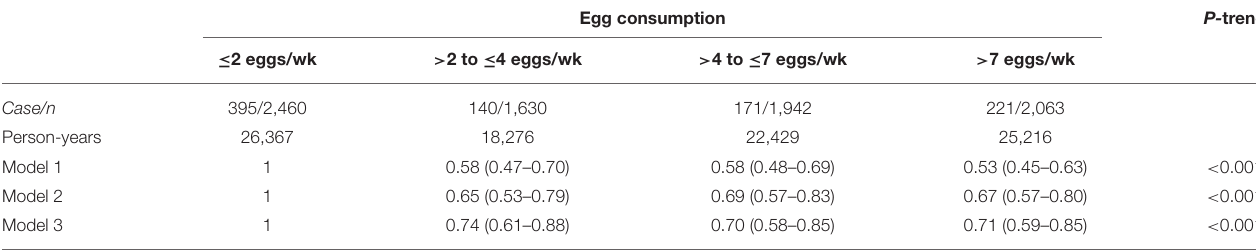
TABLE 2 | Hazard ratios (HRs) (95% CIs) of the mortality among hypertensive patients according to egg consumption ( n = 8,095) *